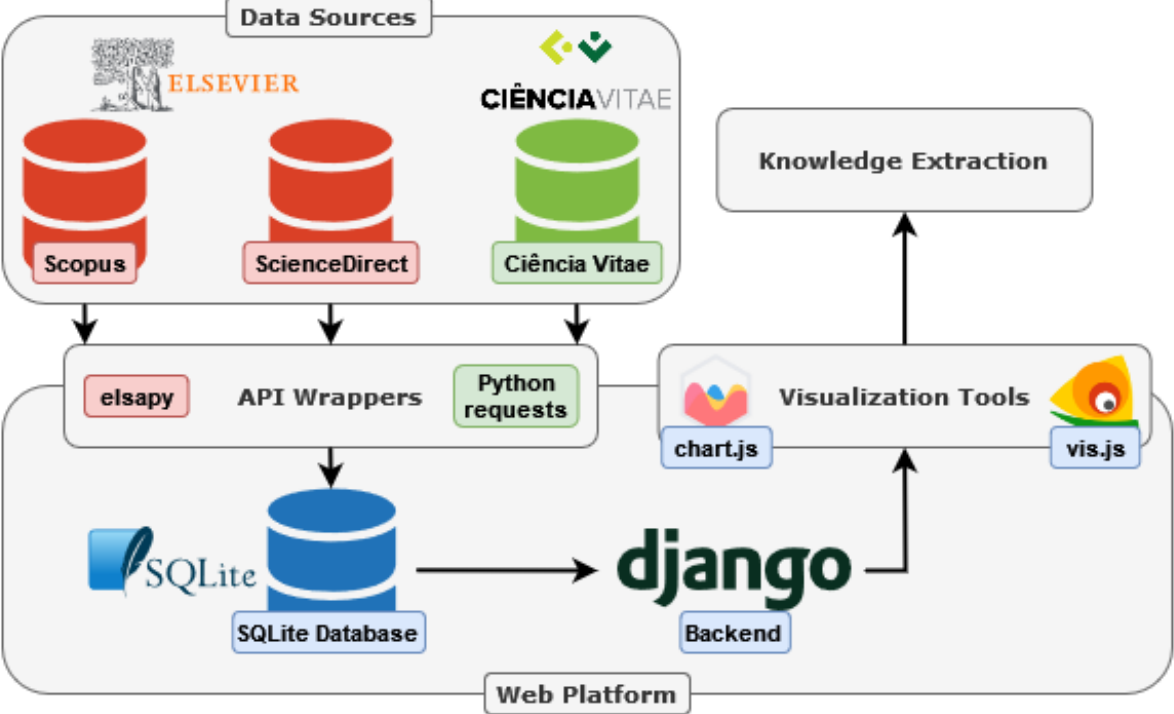
Figure 1. Main components of the web-based